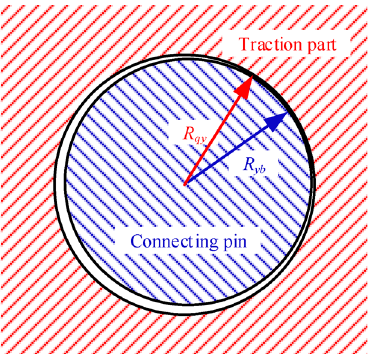
Figure 2. Schematic diagram of rocker arm pin